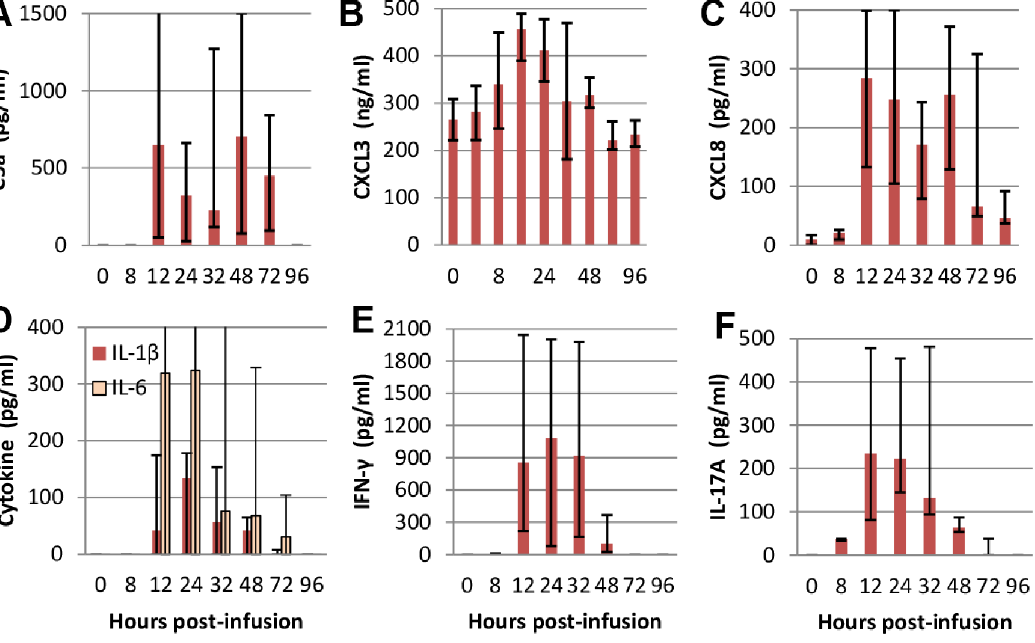
Figure 5. Concentrations of chemoattractants and cytokines in milk samples of the 9 responsive cows. Concentrations were measured by ELISA in the milk samples of the 9 responder cows. Quarters were infused with 25 m g ovalbumin at time 0 and milk samples taken at indicated times. Median values (Q1, Q3) are shown. Concentrations varied significantly (Friedman test) as a function of hpi for C5a, CXCL8, IL-1 b , IL-6, IFN- c , IL- 17A (p , 0.001) and CXCL3 (p=0.002).